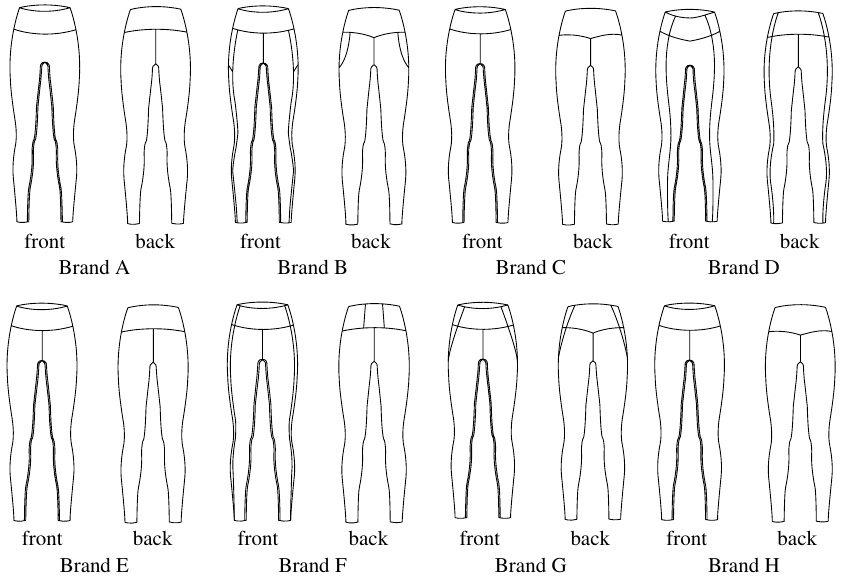
Fig. 1 Front and back schematic representation of commercial leggings by